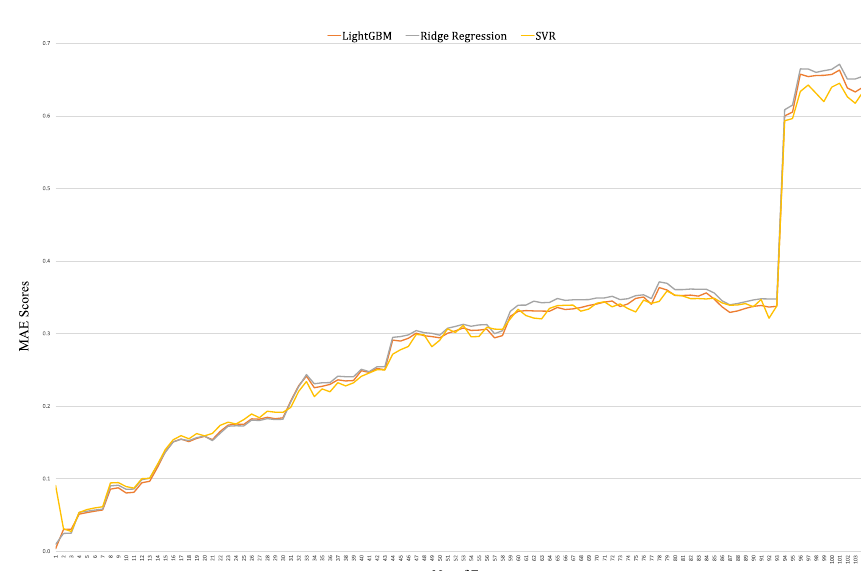
Fig. 8 Performance analysis of the baseline model with respect to MAE scores and feature